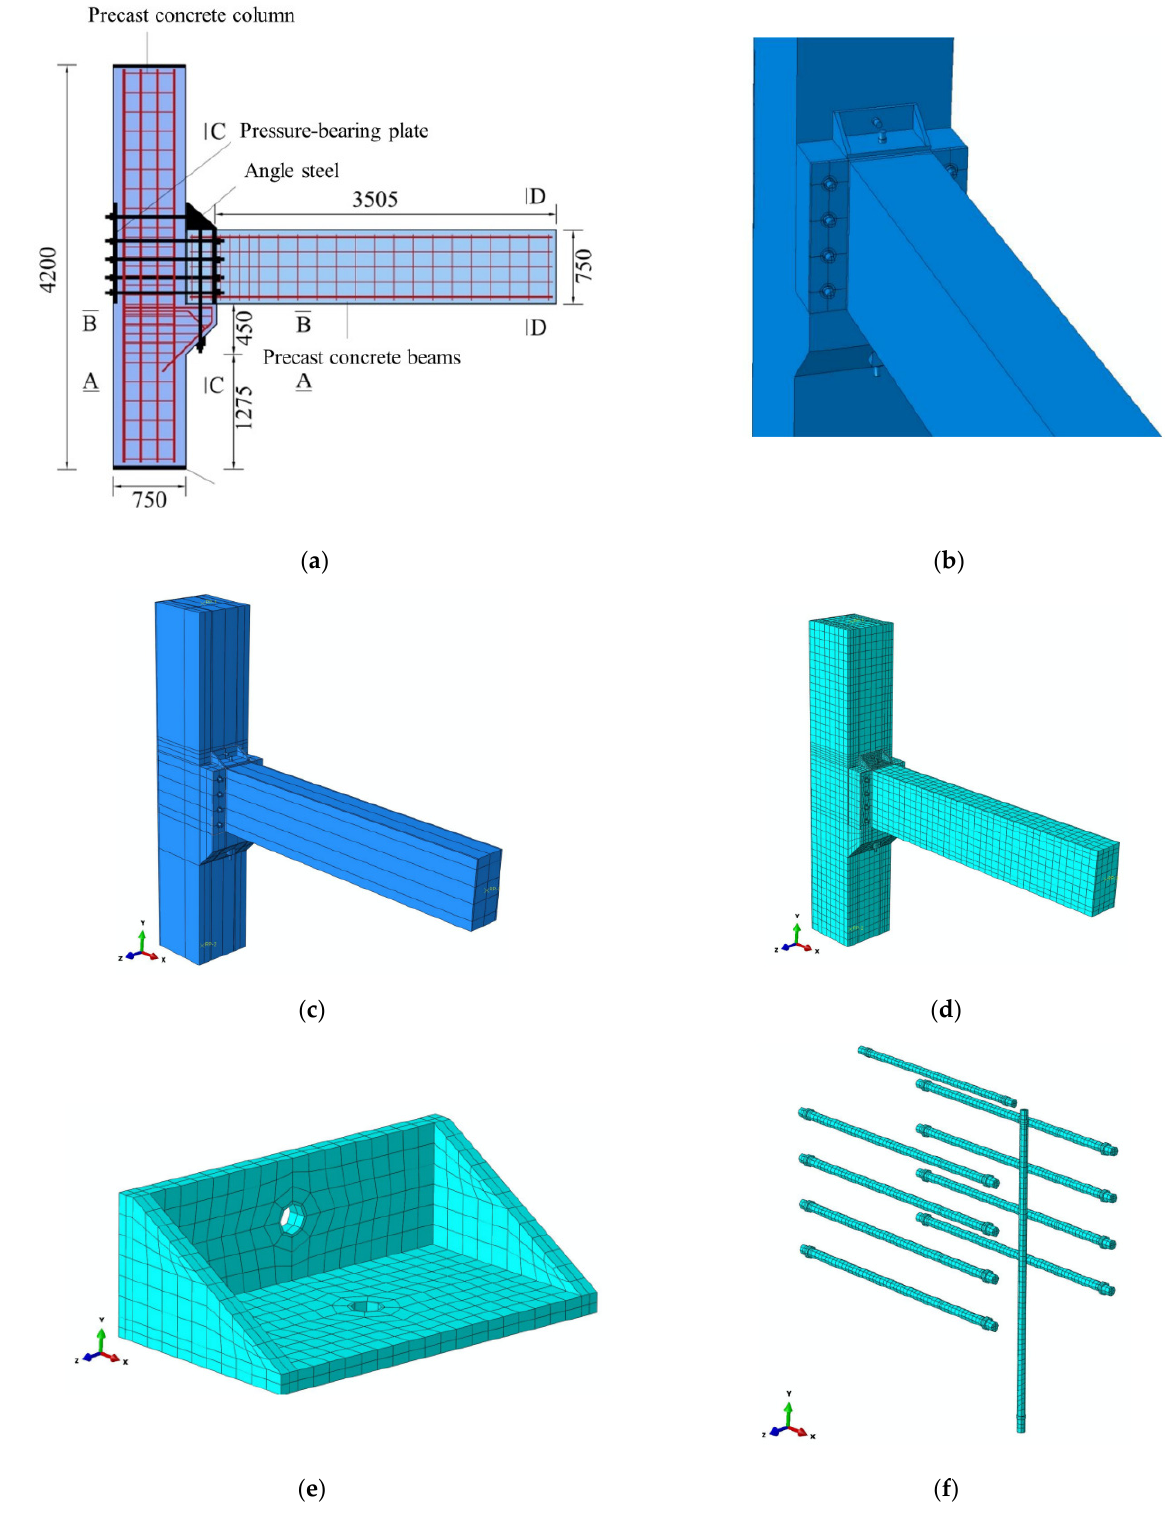
Figure 32. Details of modified node J3. ( a ) Detailed drawings of the joint structure; ( b ) finite element model; ( c ) cutting of the working surface; ( d ) meshing; ( e ) angle meshing; ( f ) bolt meshing.